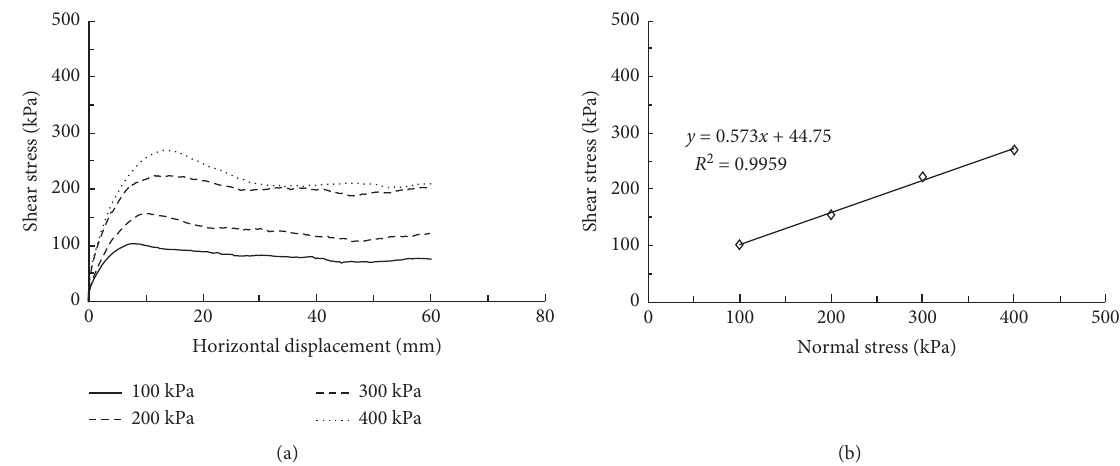
Figure 10: (a) Variation of shear stress with horizontal displacement obtained by direct shear tests on G1 with a plate opening of 5.0 mm. (b) Failure envelope for G1 (plate opening 5.0mm).